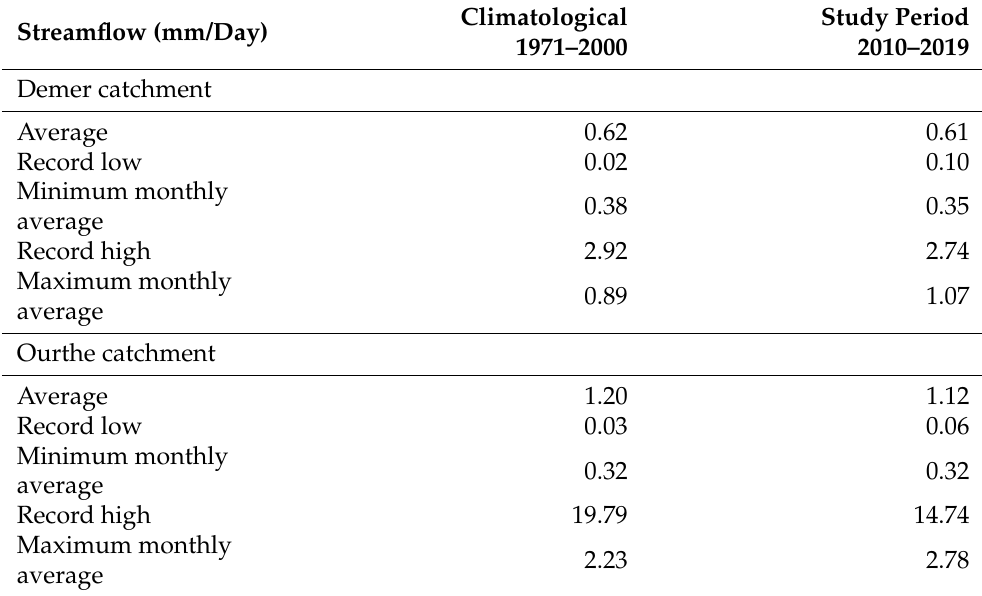
Table 1. Synoptic streamflow climatology.